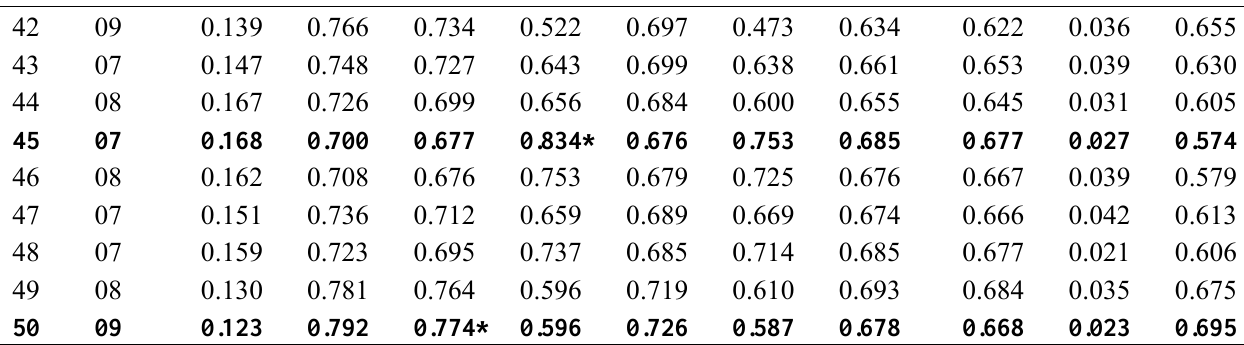
Figure 9. Comparative plots of Q 2 , R 2